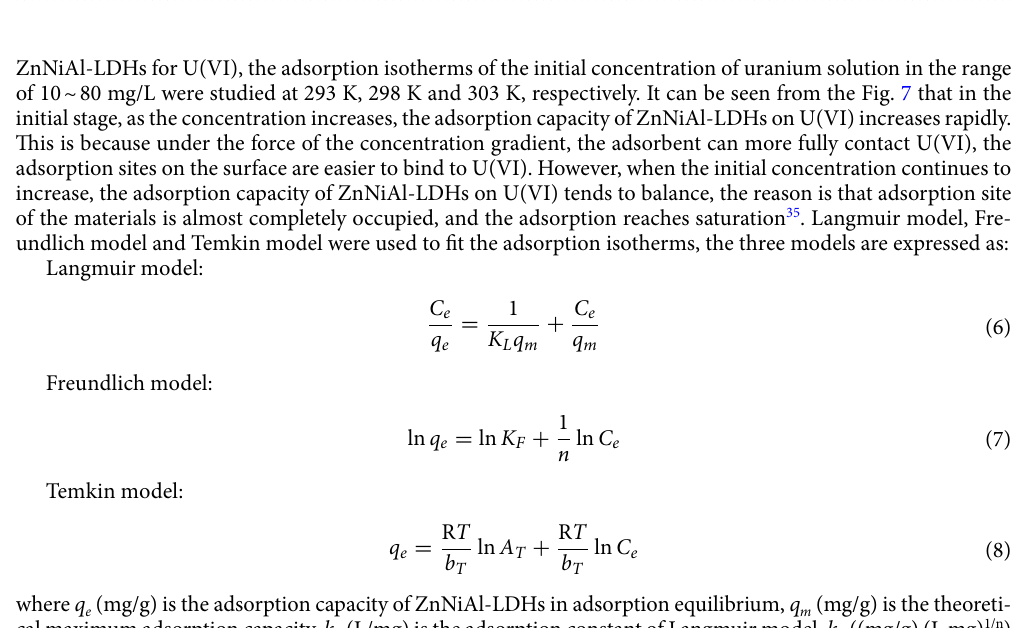
Figure 7. Adsorption isotherms of U(VI) on ZnNiAl-LDHs ( m/V = 0.125 g L −1 , pH = 6.0, t = 6